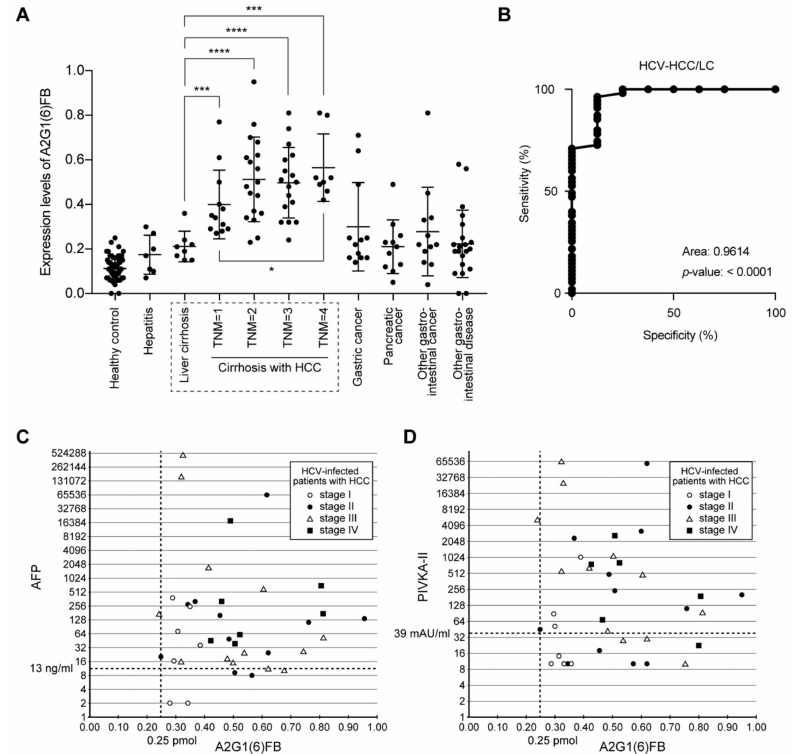
Figure 2. Serum A2G1(6)FB is a potential candidate for primary hepatocellular carcinoma (HCC) in hepatitis C virus (HCV)-dependent cirrhosis. ( A ) Scatter plots showing A2G1(6)FB level in human sera. A2G1(6)FB expression levels were significantly higher in the HCC group compared with the liver cirrhosis (LC) group. * p < 0.05, *** p < 0.001, **** p < 0.0001, Mann–Whitney test. Dotted line indicates the LC patients with or without HCC. ( B ) Receiver operating characteristic (ROC) curves for A2G1(6)FB. The area under the curve (AUC) of A2G1(6)FB was 0.9614 ( p < 0.0001) in HCV-infected patients with HCC compared with LC (see also Tables S2 and S3). ( C , D ) Correlation between A2G1(6)FB and